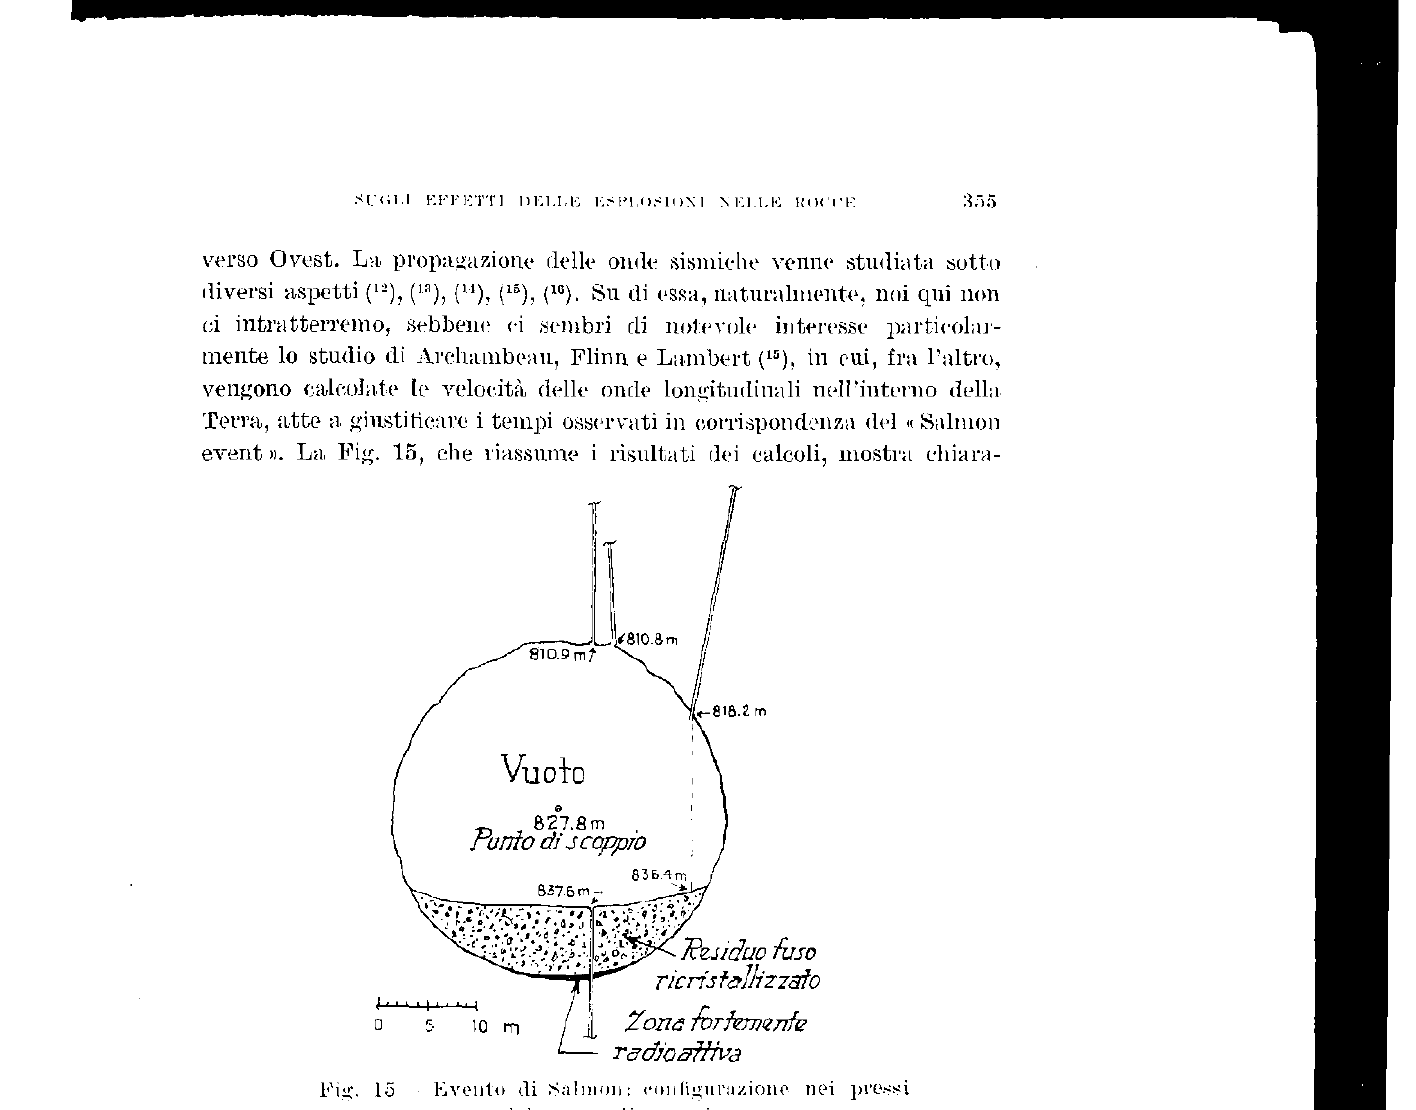
Fig. 15 - Evento di Salinoli: configurazione nei pressi del punto di